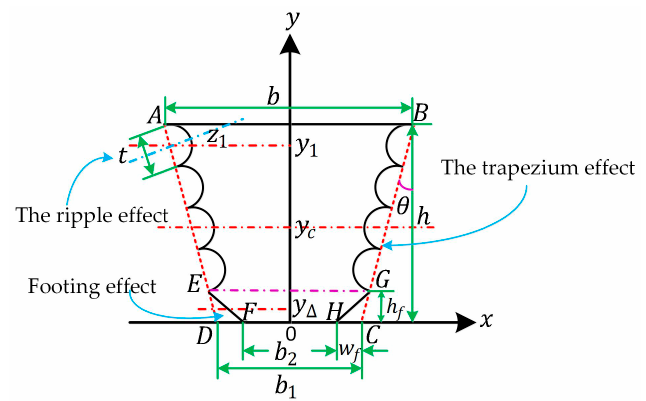
Figure 7. The coordinate sketch-map for the cross section of the doubly-clamped beam considering the three effects simultaneously (only four ripples for illustration).